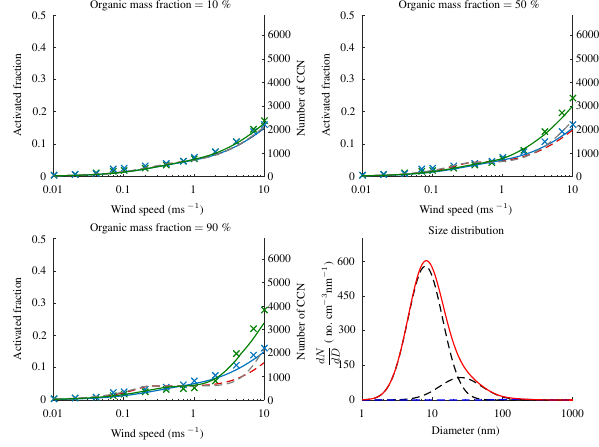
Figure 8. Same as Fig. 7 for the rural environment.